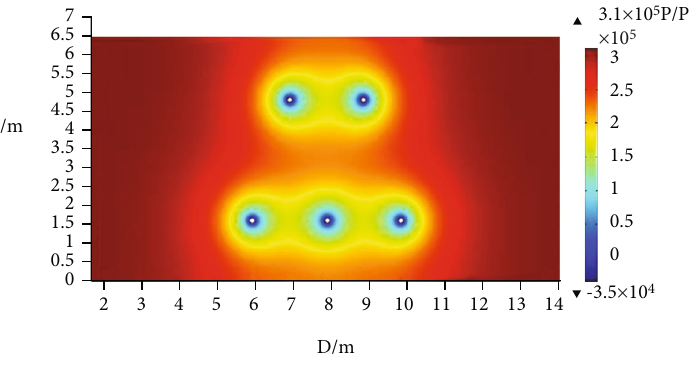
Figure 8: The gas pressure cloud diagram.